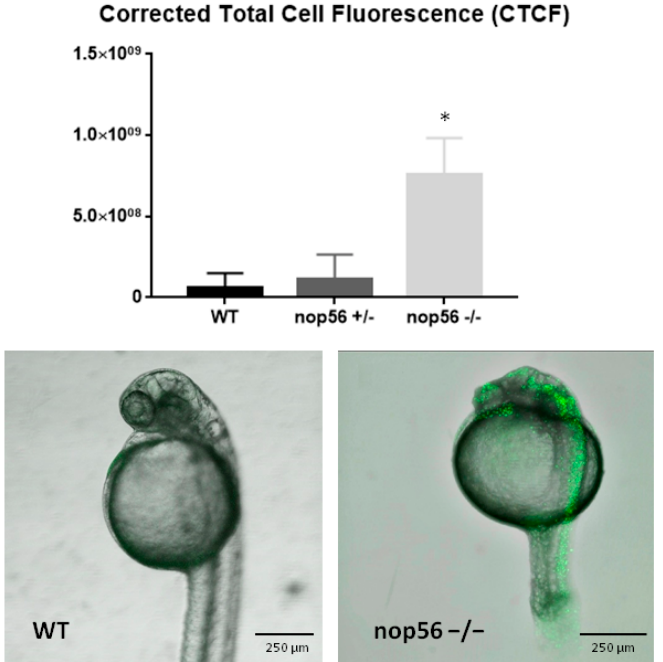
Figure 8. Apoptosis assay in wild type, nop56 +/ − and nop56 − / − . Fluorescence highlights apoptotic cells. nop56 − / − have a high increase in apoptosis mainly in CNS ( p -value < 0.0001). Statistically significant data in the graphs are indicated with a